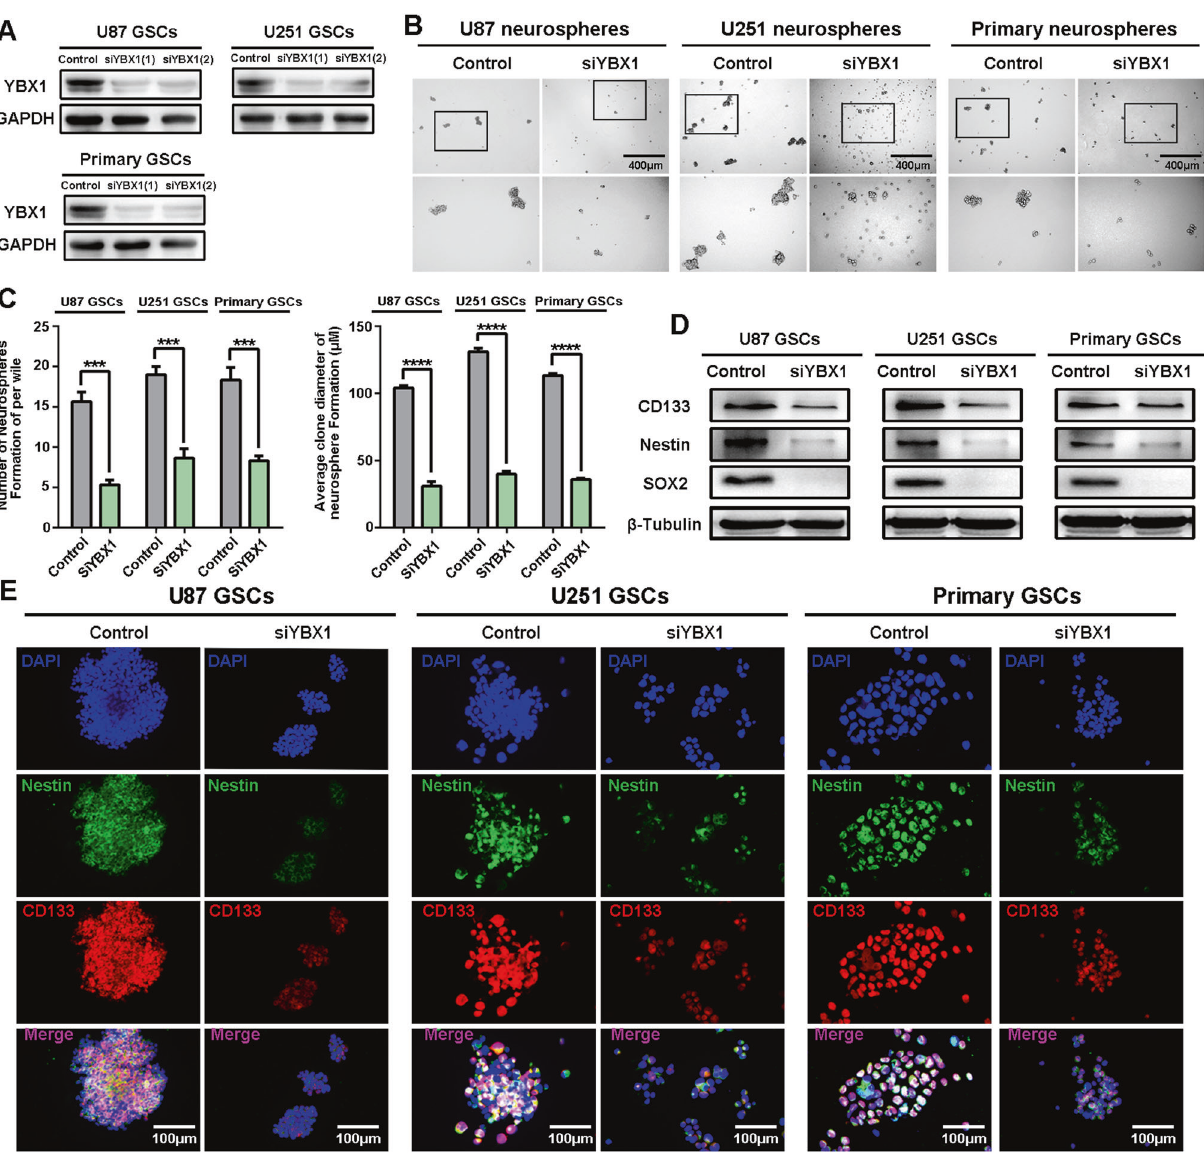
Fig. 6 YBX1 knockdown inducing apoptosis and DNA damage of GSCs. A Protein expressions of YBX1 were detected by western blot. B The representative images of GSCs neurospheres showed that neurosphere formation ability of GSCs was signi fi cantly inhibited in YBX1 knockdown cells. The outlined sections of top images were de fi ned as higher magni fi cation sections below. n = 3, scale bar = 400 μ m. C The quanti fi cation of numbers and diameter of the GSCs neurospheres shows that the neurosphere formation ability of GSCs was inhibited in YBX1 knockdown cells. Data are shown as means ± SD, n = 3, # P = NS, * P < 0.5,** P < 0.1, *** P < 0.001, **** P < 0.0001, Student ’ s t test. D U87, U251, and primary GSCs were treated with siYBX1 knockdown; protein expression of CD133, Nestin, and SOX2 was detected by Western blot. E Cells were immunostained for Nestin (green) and CD133 (red) and stained with DAPI (blue). Scale bar = 100 μ